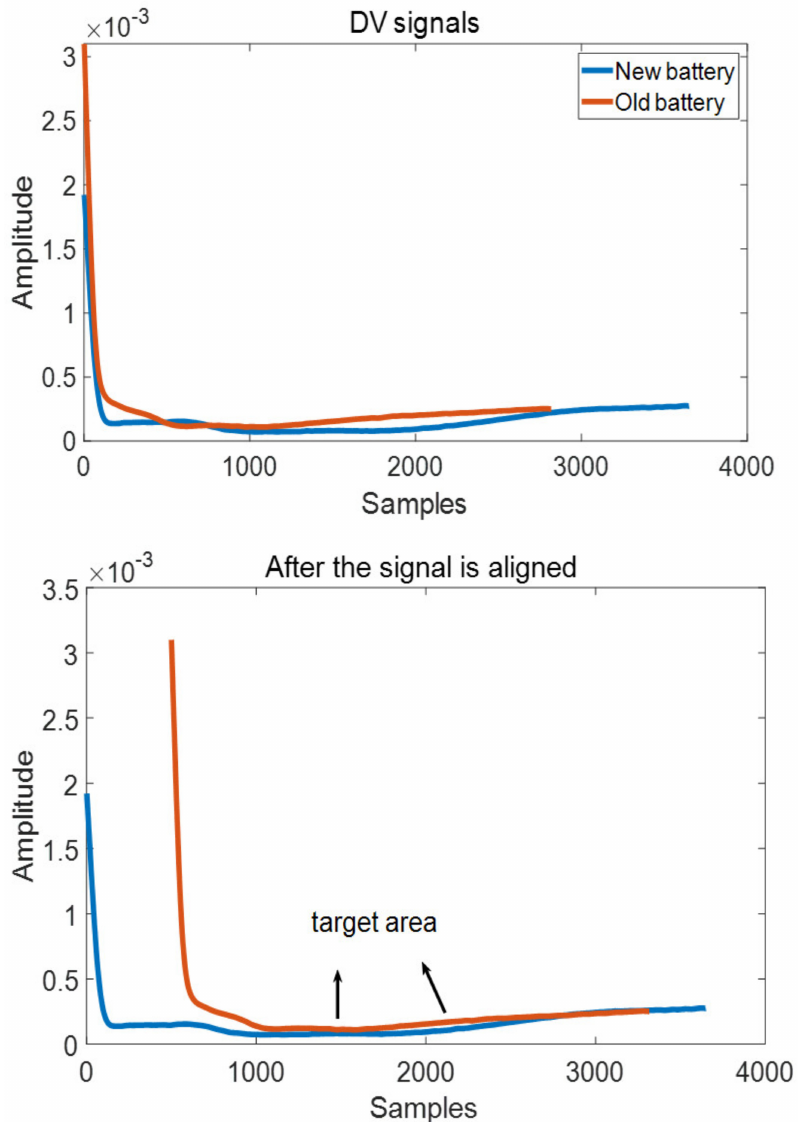
Figure 1. Comparison of DV curve of new battery and aging